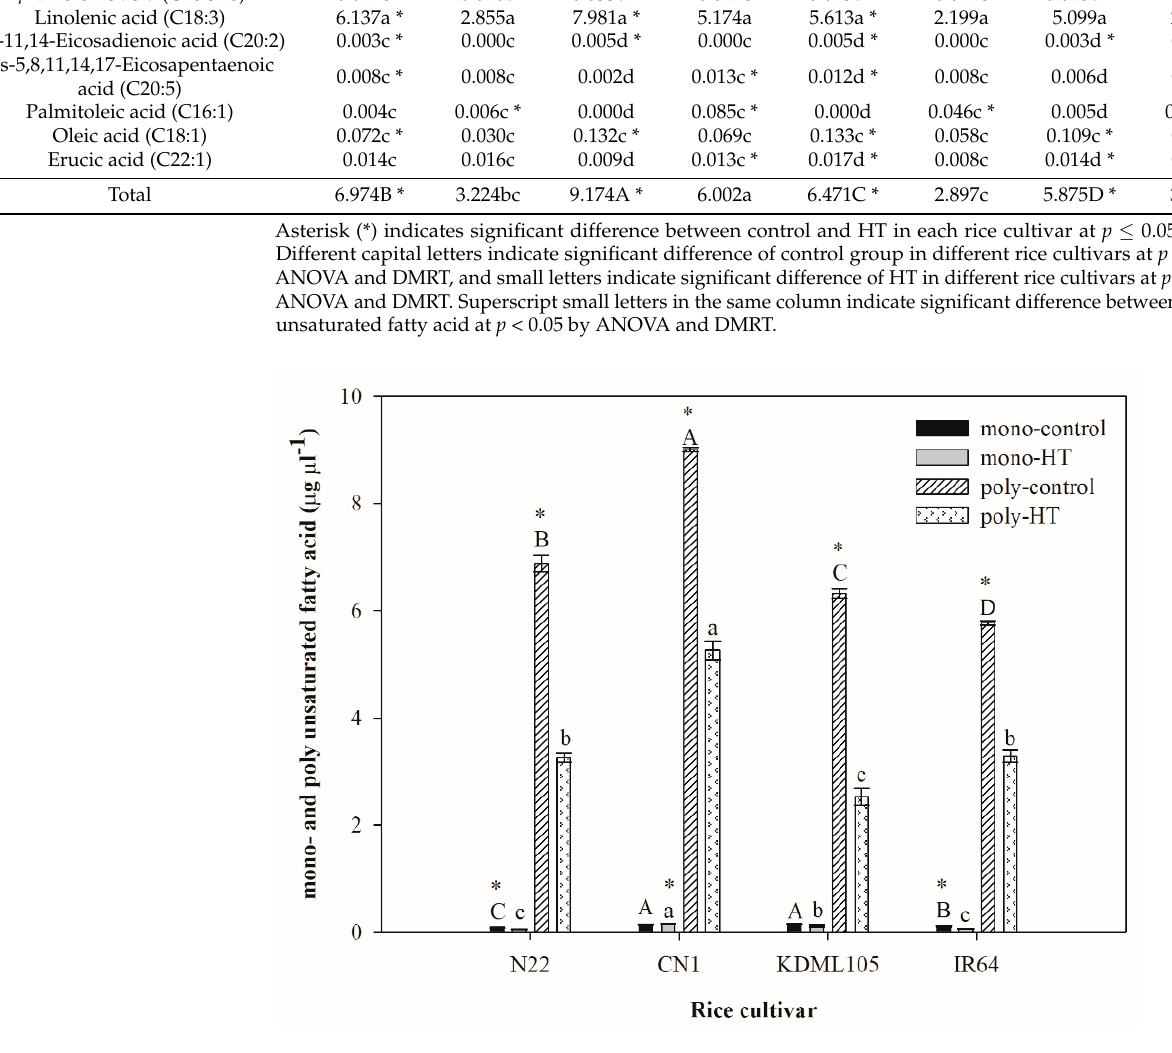
Asterisk (*) indicates significant difference between control and HT in each rice cultivar at p ≤ 0.05 by t test. Different capital letters indicate significant difference of control group in different rice Table 2. Unsaturated fatty acids in the control and HT-stressed leaves of four rice cultivars. cultivars at p ≤ 0.05 by ANOVA and DMRT, and small letters indicate significant difference of HT in different rice cultivars at p ≤ 0.05 by ANOVA and DMRT. Superscript small letters in the same N22 CN1 Unsaturated Fatty Acids ( µ g µ L − 1 ) column indicate significant difference between different unsaturated fatty acid at p < 0.05 by ANOVA and DMRT.